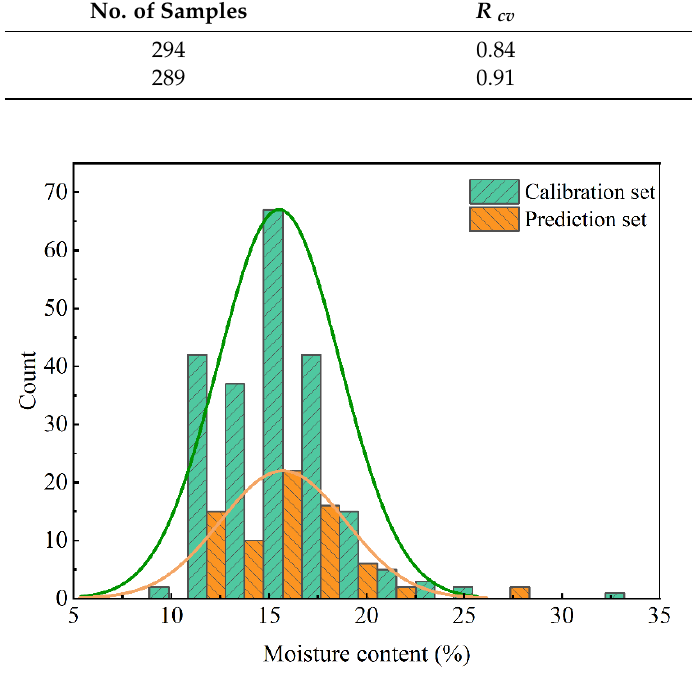
Table 1. The results of cross-validation of PLSR model based on S1 spectra.